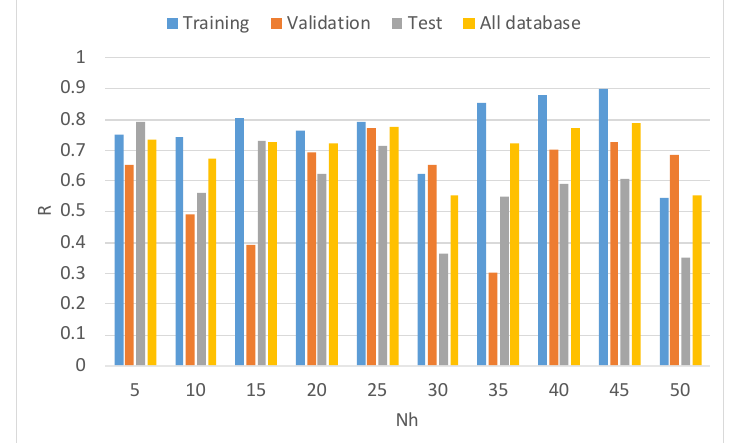
Figure 7. Pearson’s correlation coefficient R between the target and predicted solution time for one training, validation, and test part of the Dice 1 dataset and for the whole dataset varying the number of neurons ( N h ) in the hidden layer of the ANN model.